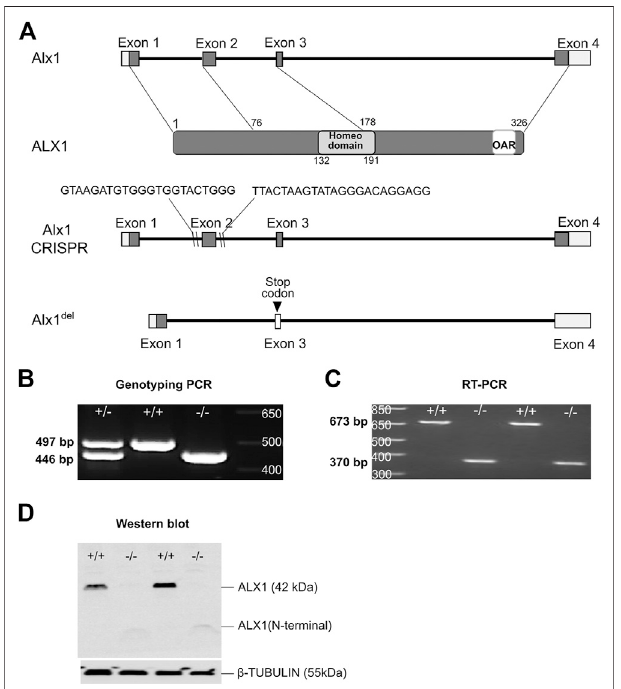
FIGURE 1 | Generation of Alx1 -deletion mice using CRISPR/Cas9- mediated genome editing. (A) Schematics of the strategy for generating Alx1 del/+ mice using the CRISPR/Cas9 technology. The top row shows the genomic organization of the mouse Alx1 locus. Exons 1 – 4 are boxed with coding regions fi lled in grey color and the domains of ALX1 protein represented in the second row. Lines point to the exons of the Alx1 gene with the corresponding region in the ALX1 protein. The DNA-binding Homeodomain and the OAR domain, a conserved domain in the C-terminal region of several paired-like homedomain proteins including Drosophila Orthopedia and Aristaless and vertebrate Rax, are marked. The locations of sgRNA target sequences are indicated in intron-1 and intron-2 regions, respectively, in the schematic in the third row, whereas the fourth row depicts the Alx1 del allele that lacks exon-2 and fl ankingsequences in between the two sgRNA target sites. The exon-2 deletion results in a frameshift and premature translational STOP codon in the exon-3 sequence. (B) PCR genotyping of the embryos from the intercross of heterozygous Alx1 del/+ mice. The amplicons from wildtype and Alx1 del alleles are 497 bp and 446 bp, respectively. (C) RT- PCR analysis using primers from exon1 to exon4, respectively, reveals a wildtype amplicon of 673 bp and an Alx1 del allele-speci fi c product of 370 bp. (D) Western blotanalysisusing apolyclonalanti-ALX1 antibodyraisedagainst the full-length ALX1 protein reveals a lack of the full-length ALX1 protein in the Alx1 del/del embryos. Alx1 del/del embryos produced a truncated N-terminal product of around 10.5 kDa +/- , Alx1 del/+ ; +/+ , wildtype; − / − , Alx1 del/del .